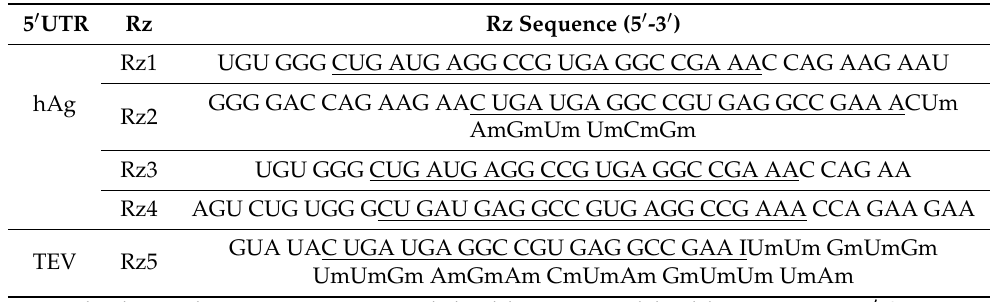
Table 1. Characteristics of the designed